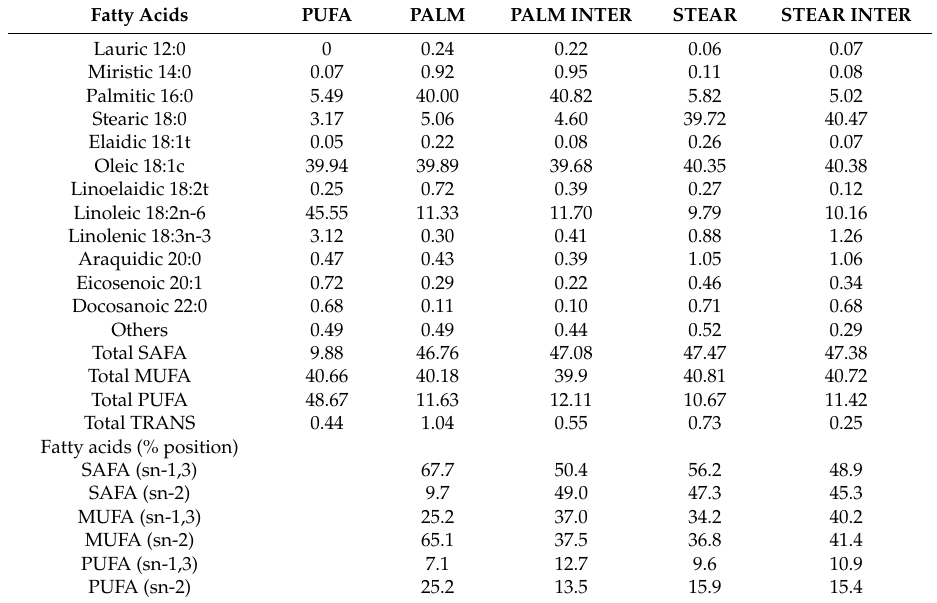
Table 1. Fatty acid composition of fats (percentage of total fat) and regiospecific distribution of fatty acids in sn-1,3 and sn-2 positions in triacylglycerols of PALM, PALM INTER, STEAR, and STEAR INTER fats. Fatty Acids PUFA PALM PALM